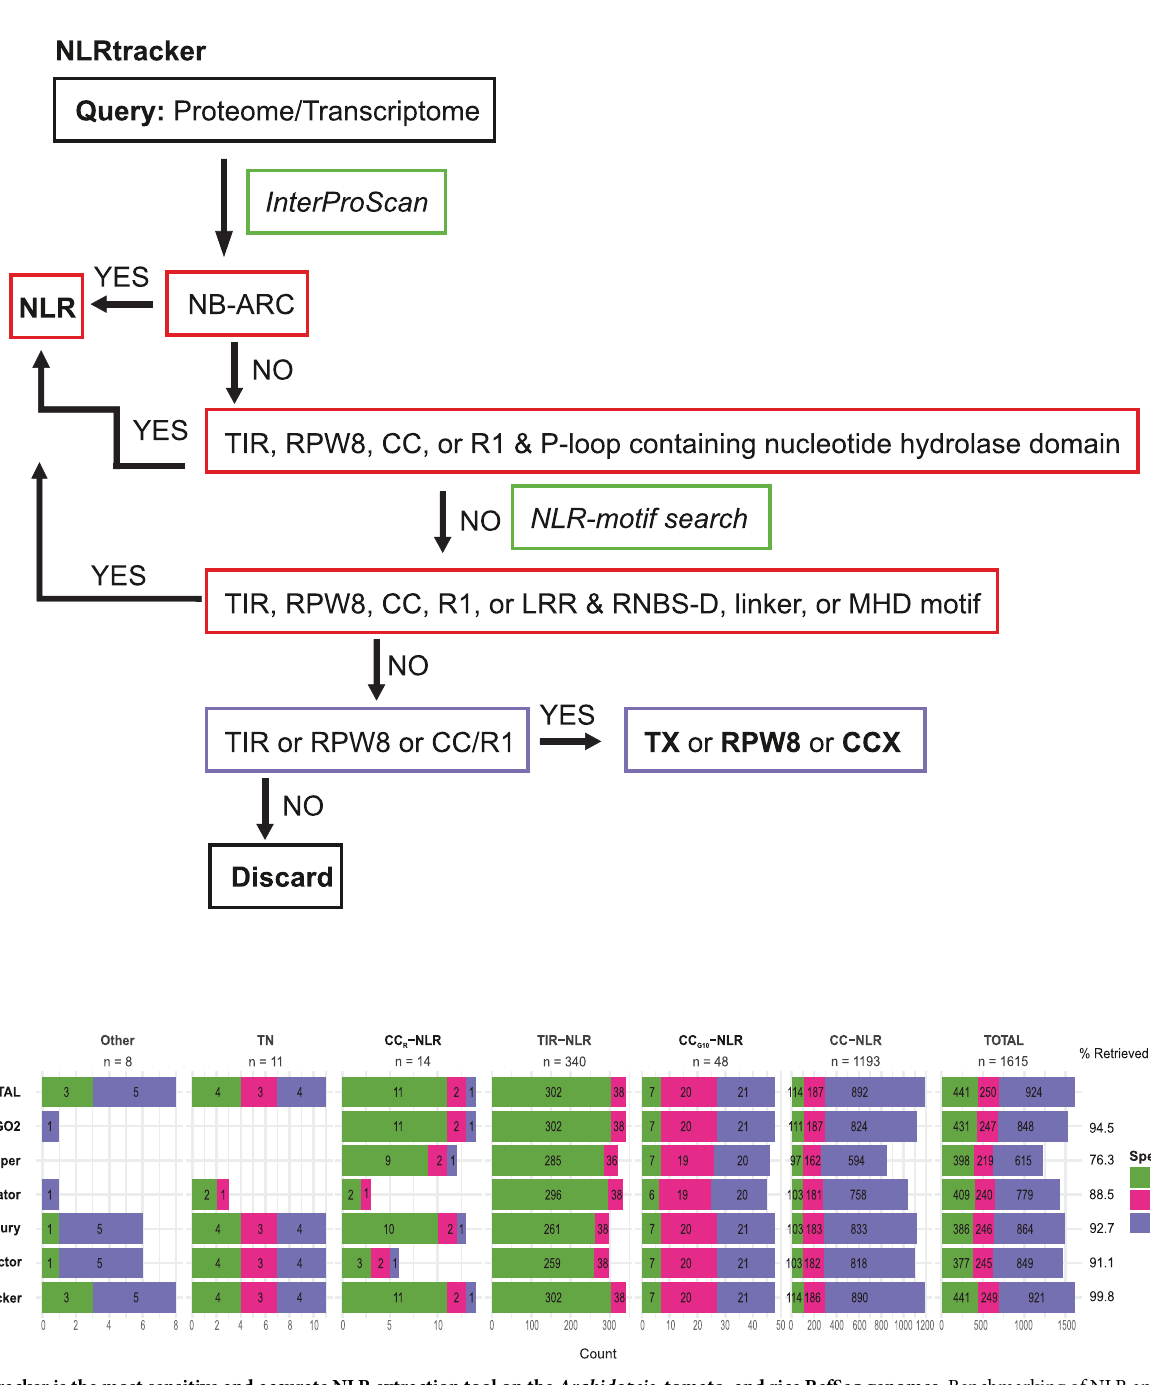
Fig 6. NLRtracker is the most sensitive and accurate NLR extraction tool on the Arabidopsis , tomato, and rice RefSeq genomes. Benchmarking of NLR annotation tools using the Arabidopsis , rice, and tomato RefSeq genomes. ( A) NLRtracker pipeline. InterProScan and predefined NLR motifs are used to group sequences into different categories. ( B) Number of NLRs retrieved in each NLR subclass per species. Underlying data and R code to reproduce the figures in S3 Appendix . CC, coiled- coil; LRR, leucine-rich repeat; NB-ARC, nucleotide-binding adaptor shared by APAF-1, certain R gene products, and CED-4; NLR, nucleotide-binding leucine-rich repeat; TIR, Toll/interleukin-1